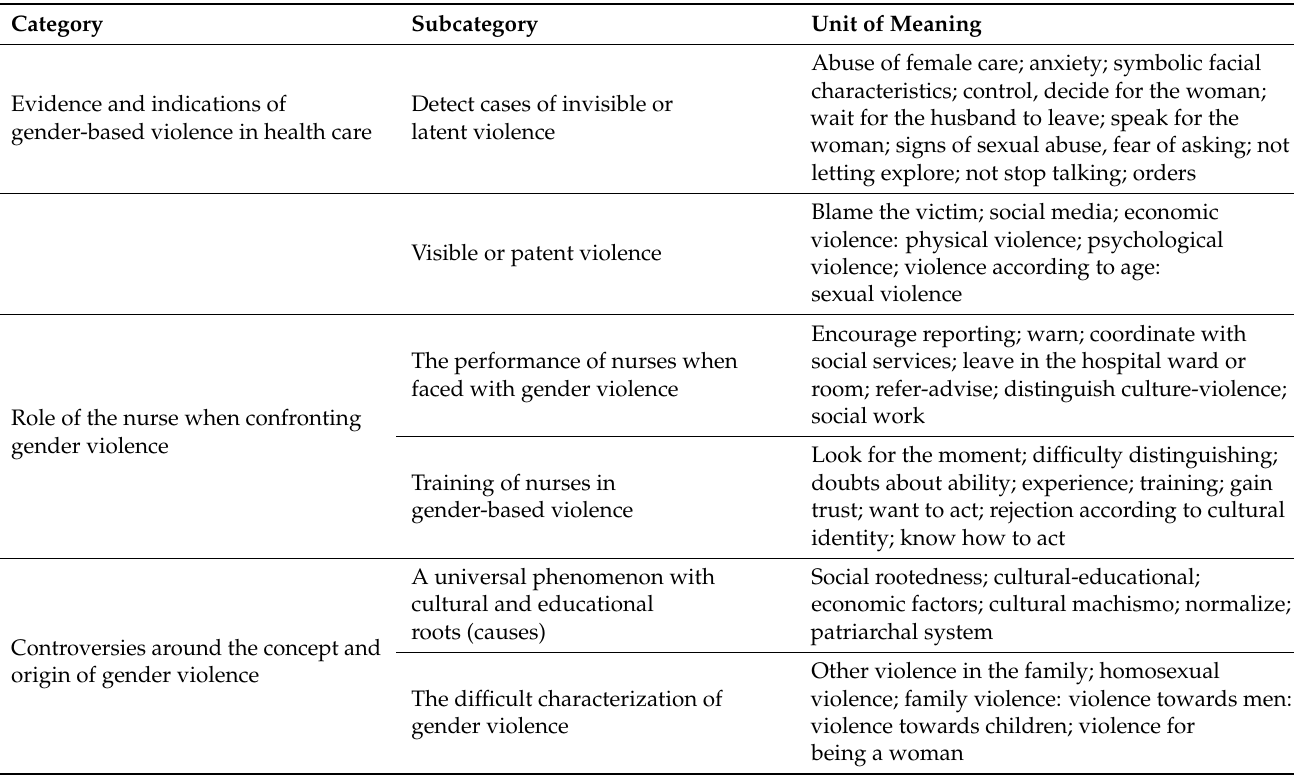
Table 3. Categories, subcategories, and units of